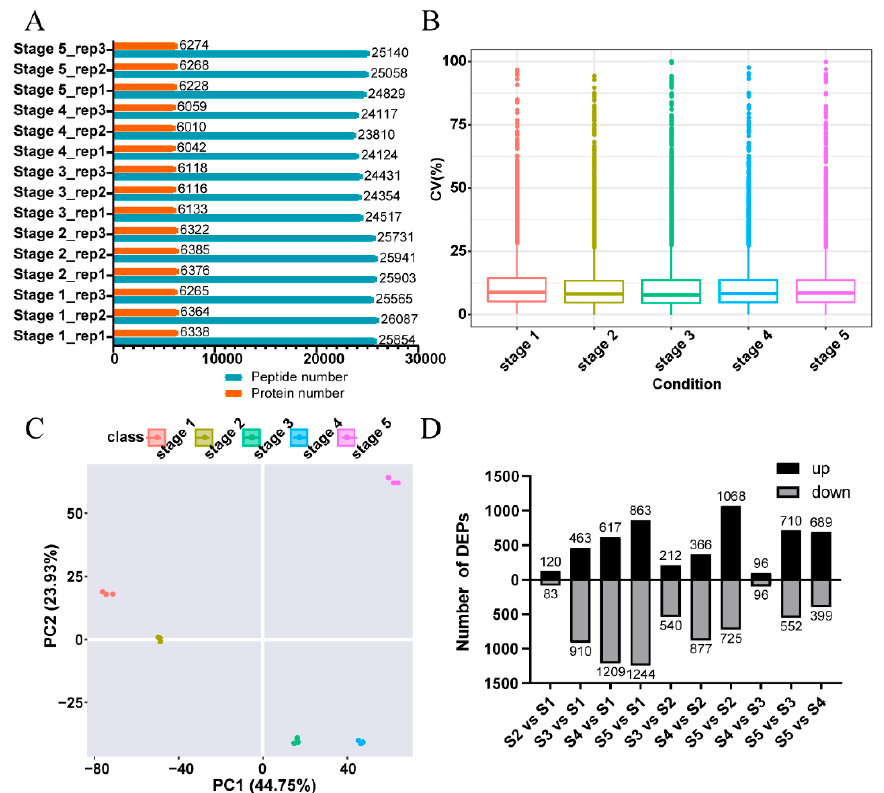
Figure 1. An overview of the quantitative proteomics analysis: ( A ) Statistics of the proteins and peptides identified in each sample. Each stage includes three replications. The ‘rep’ represents ‘replication’ on the y-axis. ( B ) Distribution of intra-group coefficient of variation (CV) for each sample. ( C ) Principal component analysis (PCA) of the quantified proteins for each sample. ( D ) Statistics of differentially abundant proteins (DAPs) in each comparison group. S1, S2, S3, S4, and S5 represent stage 1, stage 2, stage 3, stage 4, and stage 5, respectively.